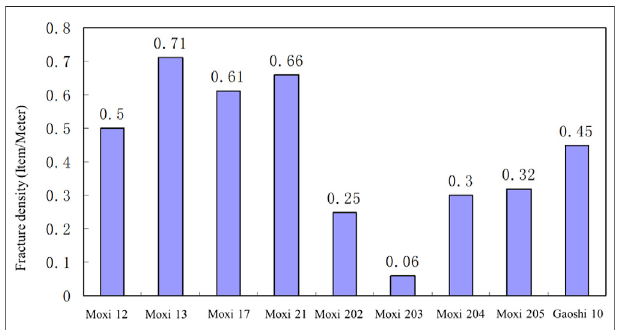
FIGURE 8 | Histogram of fracture development in the Lower Cambrian Longwangmiao Formation reservoir in central Sichuan.